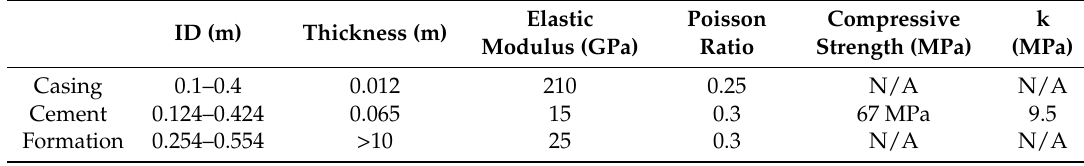
Table 2. Parameters of the casing, cement and formation.